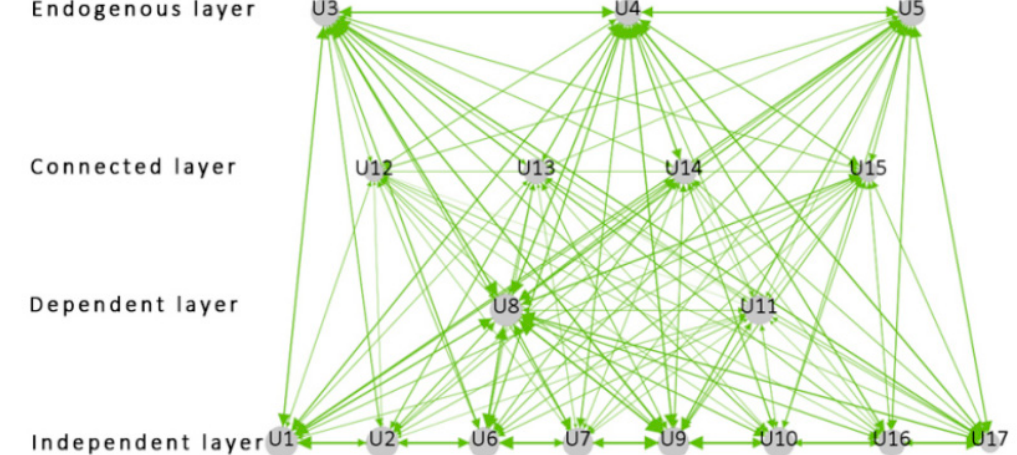
Figure 5. Relationship diagram of vulnerability factors of traffic flow in dense waters.